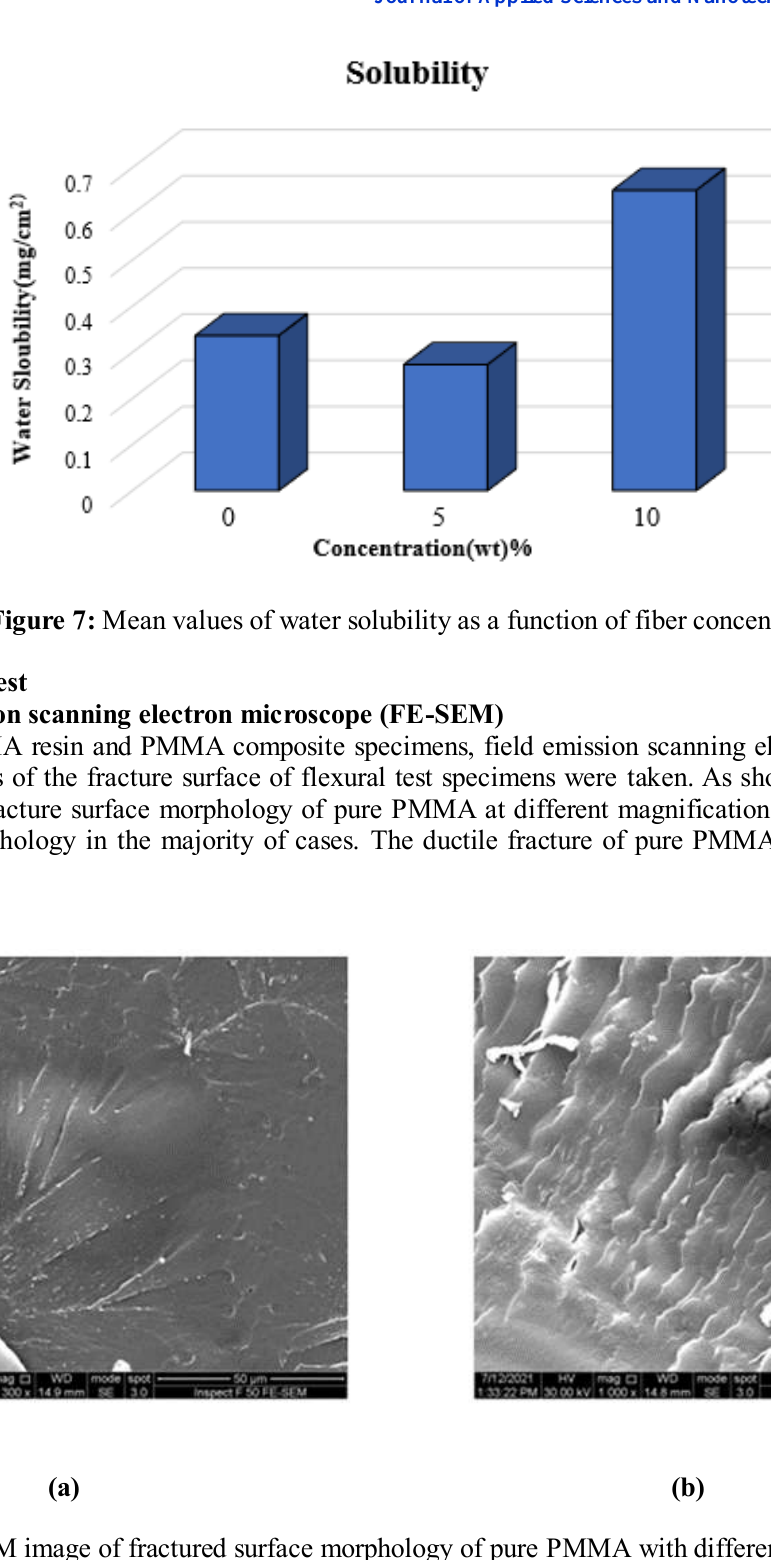
Figure 8: FE-SEM image of fractured surface morphology of pure PMMA with different magnification,(a)FE- SEM magnification 2000x, 50 µ m, (b) FE-SEM magnification 1000x, 100 µ m . FE- SEM images of the fracture surface morphology of PMMA reinforced with 5% wt and 10% wt of sisal